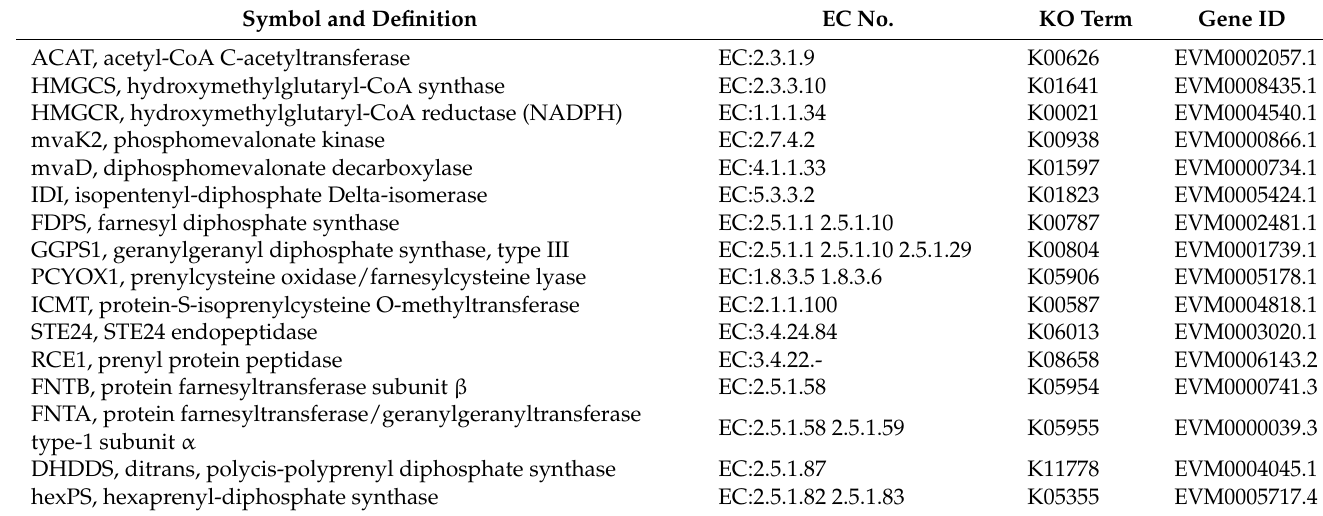
Table 4. Putative genes involved in terpenoid backbone